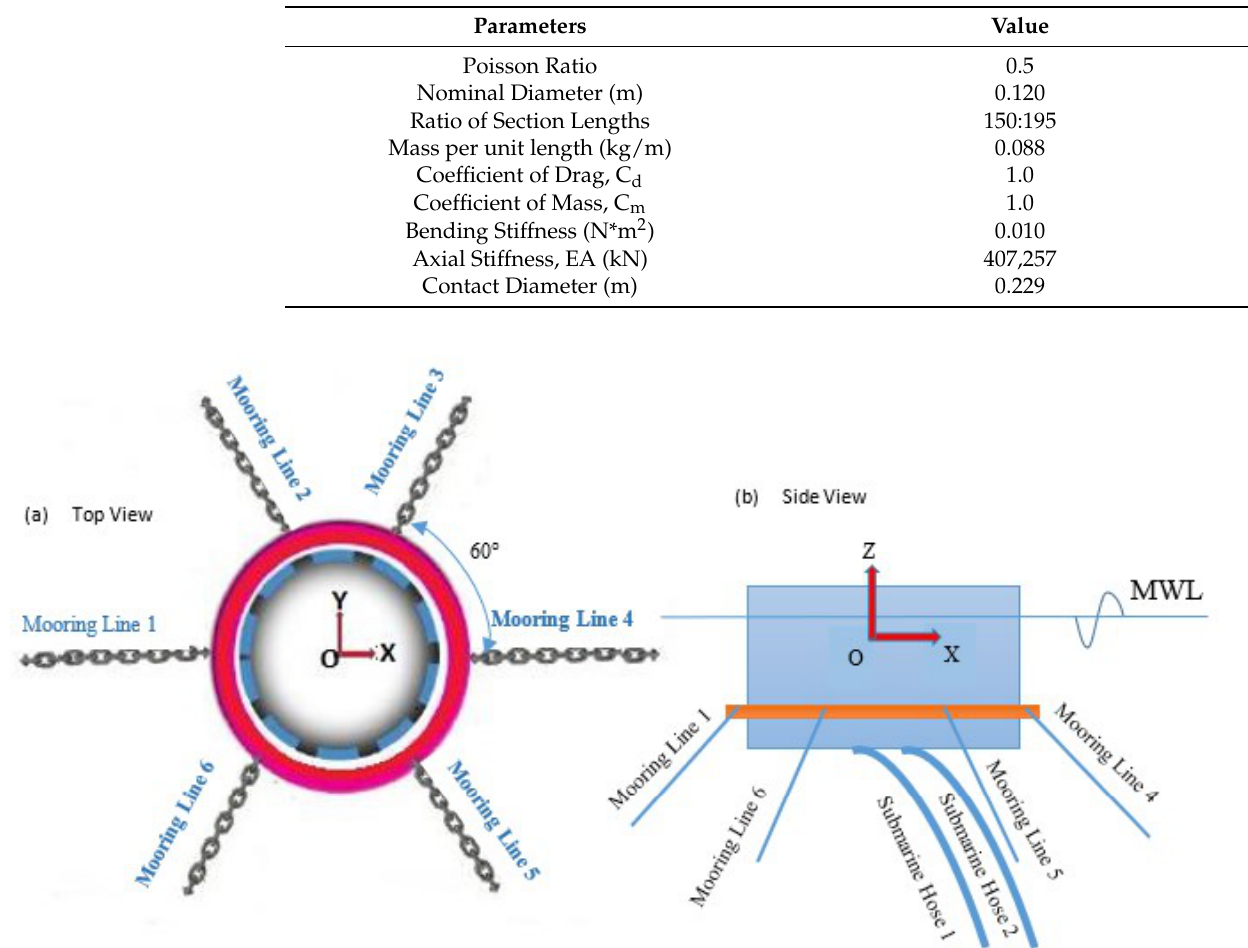
Figure 8. The Cartesian Coordinate System showing the Buoy and Mooring Lines in ( a ) top view ( b ) side view .